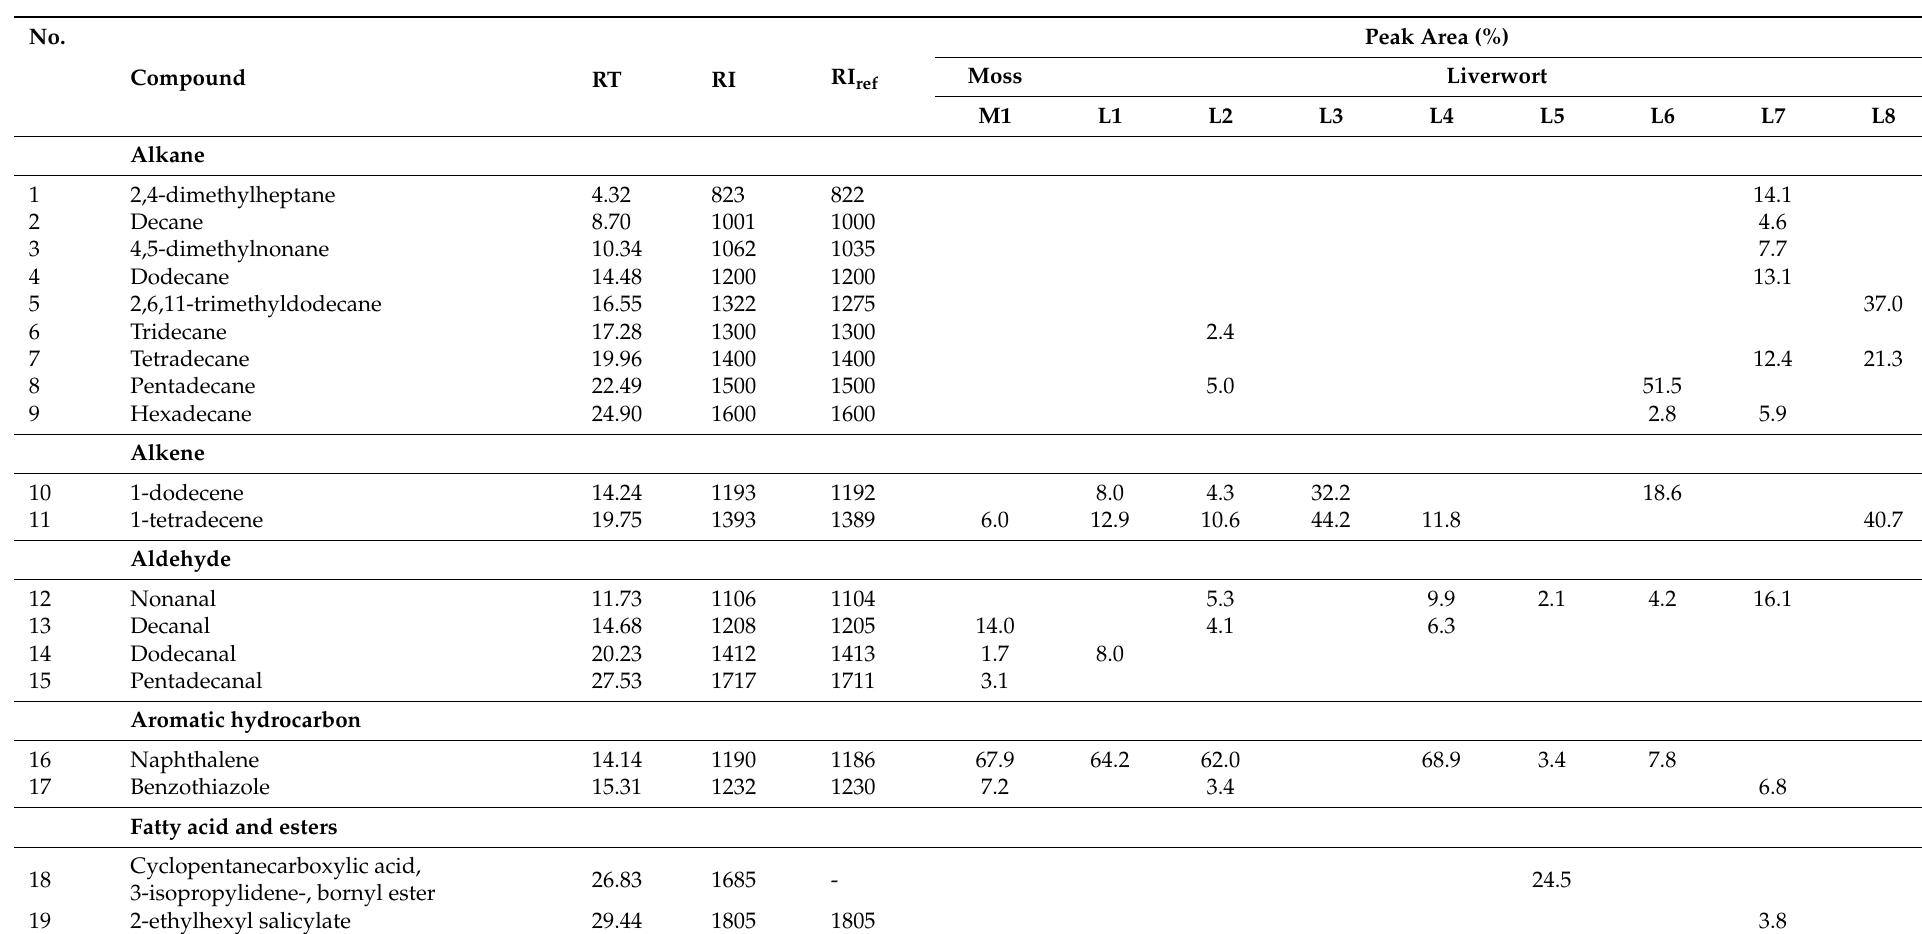
Table 4. Major volatile compounds identified in bryophyte headspace from Lata Belatan. RT: retention time; RI: retention index; RI ref : retention index in reference. Mosses—M1: Oedicladium pseudorufescens . Liverworts—L1: Drepanolejeunea ternatensis , L2: Pallavicinia lyellii , L3: Bazzania asymmetrica , L4: Pycnolejeunea cavistipula